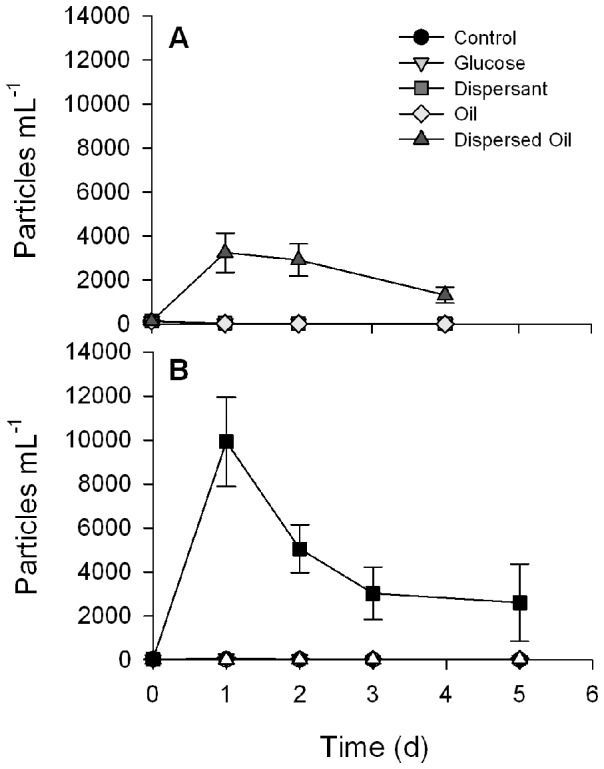
Number of spherical particles 3–20 µm in diameter in each treatment over time.June (A) and August (B) both show a rapid increase in particles in the Dispersed Oil treatment at t = 1 d, with a decrease overtime. This decrease was likely due to small particles clumping together and becoming larger than 20 µm. Small differences were observed for the other treatments, but they were not significantly different from each other.